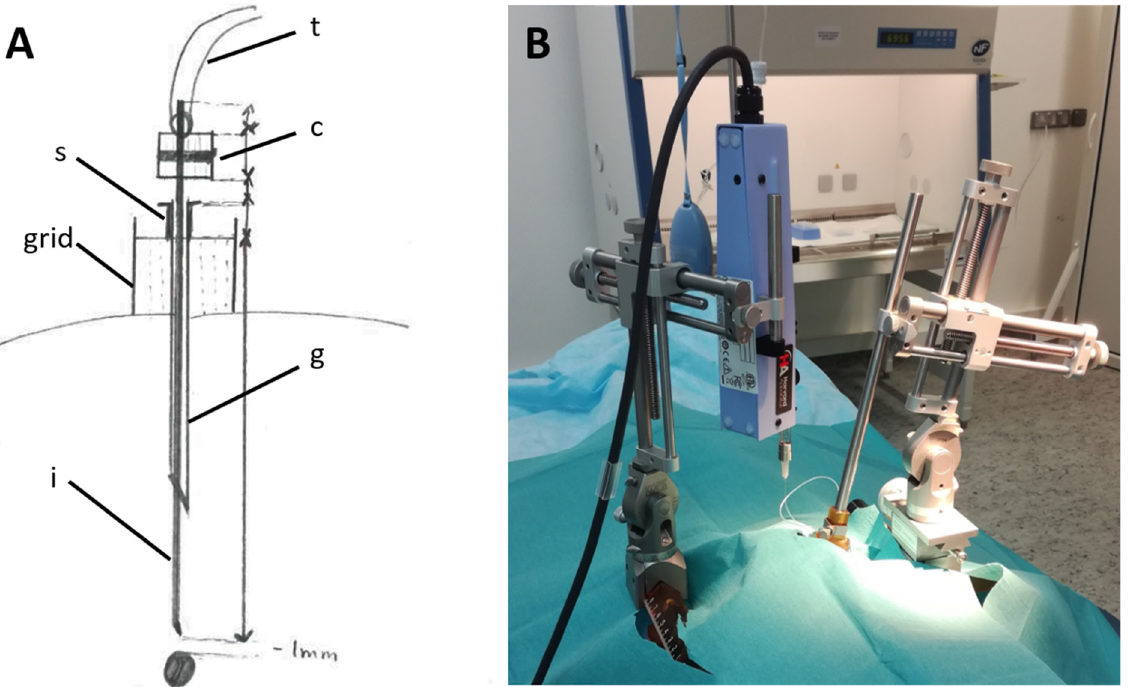
Figure 2. Injecting the viral construct. ( A ) Injecting system: First, the guide-tube ( g ) is inserted into one of the grid holes. A spacer ( s ) prevents the guide-tube from descending under the surface of the grid. Then, the injector ( i ) is lowered into the brain through the guide-tube until it reaches the target (1 mm above the LC). It is held in place by the needle holder and connected ( c ) to the flexible tubing ( t ). ( B ) During an injection: The two manipulators are mounted on the stereotaxic frame, one holding the Hamilton syringe (left), the other holding the injecting system (right), both connected to each other by the flexible tubing. Here, the injector is already in position in the brain.